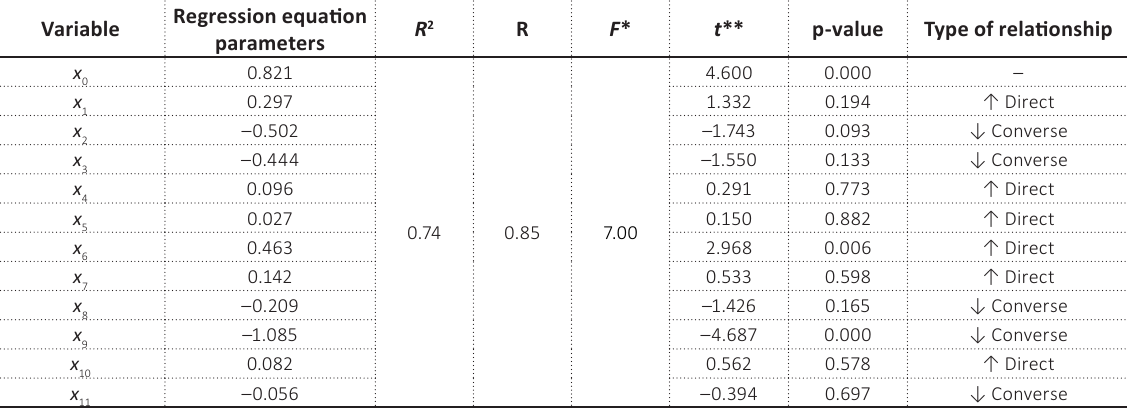
Source: Authors’ calculations.